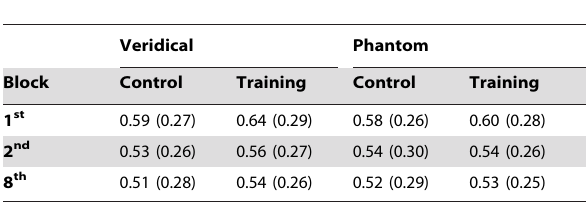
Table 3. The mean and SD (in parentheses) of response times (s) for veridical and phantom trials split over the groups for the 2 nd session.